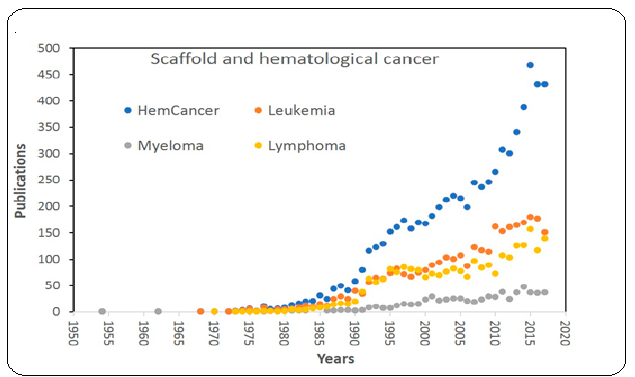
Figure 1. Hematological cancer data visualization: Published articles on BMTE with respect to hematological malignancies such as leukemia, lymphoma, and myeloma.